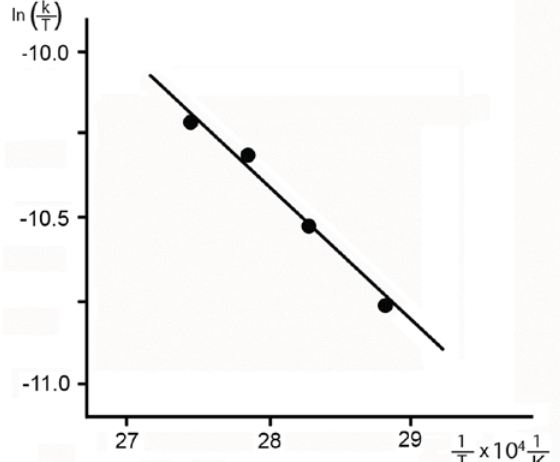
1(S) mechanism, (iii) S 2(S) N N